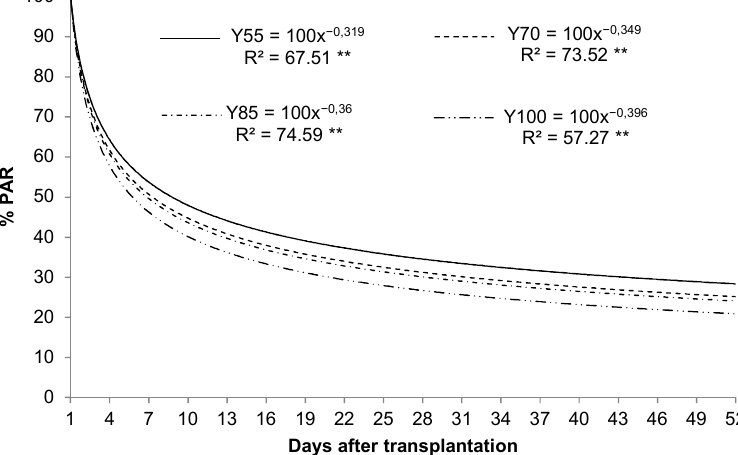
Figure 2. Percentage of photosynthetic active radiation (PAR) that reached the canopy of lettuces for the four population densities of the cucumber. ** Significant equations at 1% in the F test.